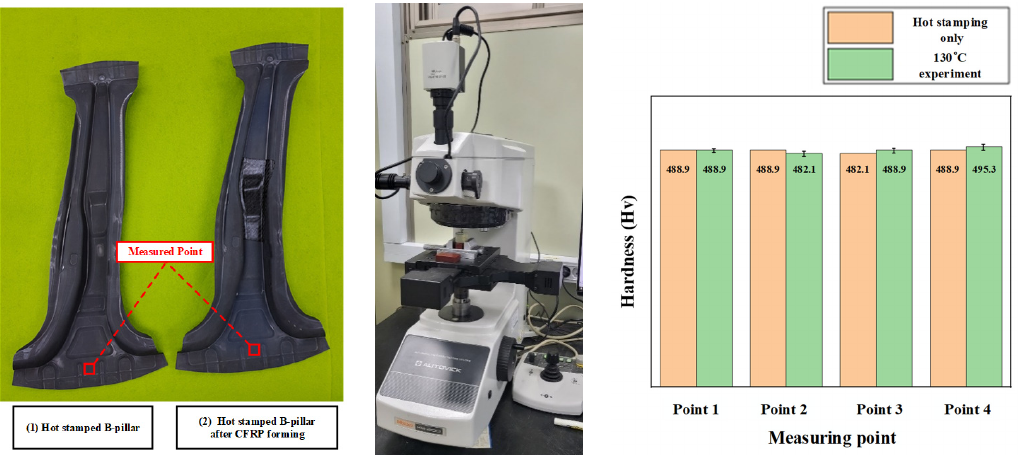
Figure 16. Comparison of the hardness between the hot stamped and PCM-tested B-pillar.